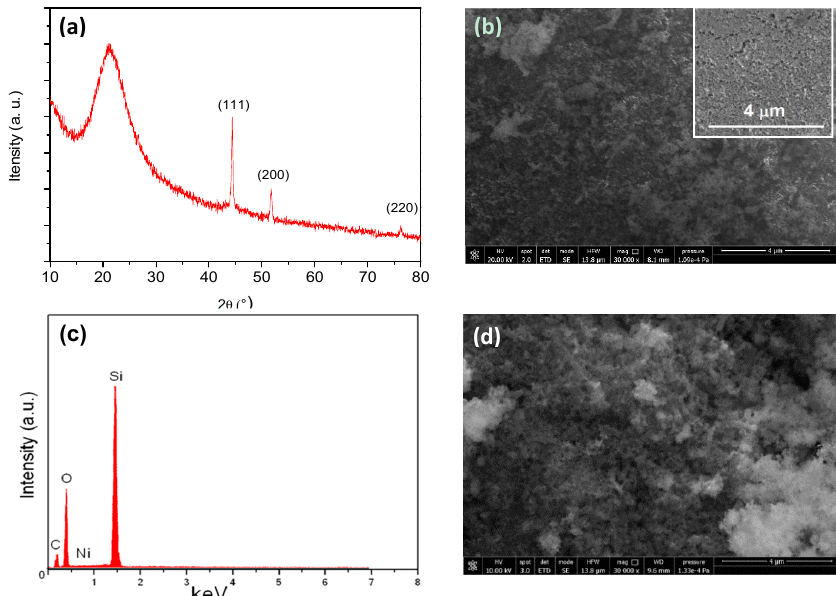
Figure 1. ( a ) XRD spectra, ( b ) SEM image of as-prepared N-CS powder, ( c ) EDS spectra, and ( d ) SEM image of the N-CS composite modified SPCE after the electrochemical activation. Inset in Figure 1b shows the surface of bare SPCE.